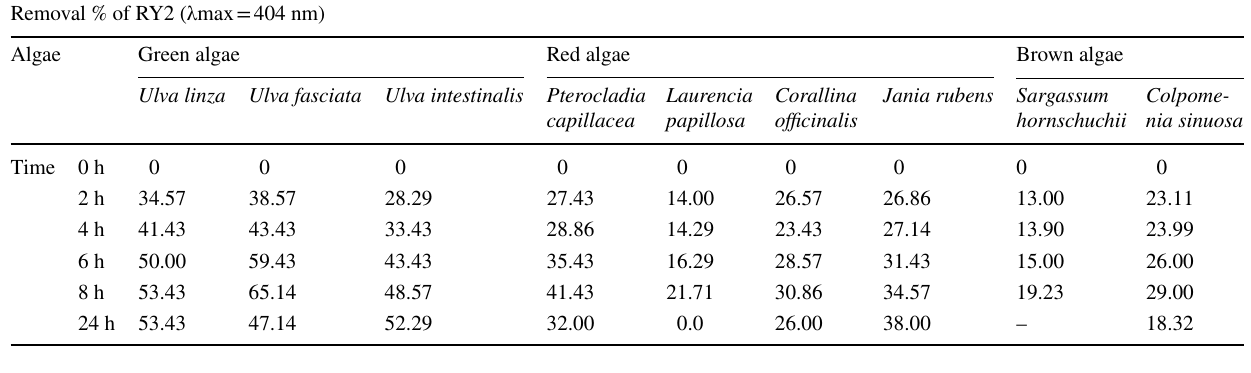
Fig. 7 Removal percentage of Reactive Yellow 2 by the nine studied dried algal species